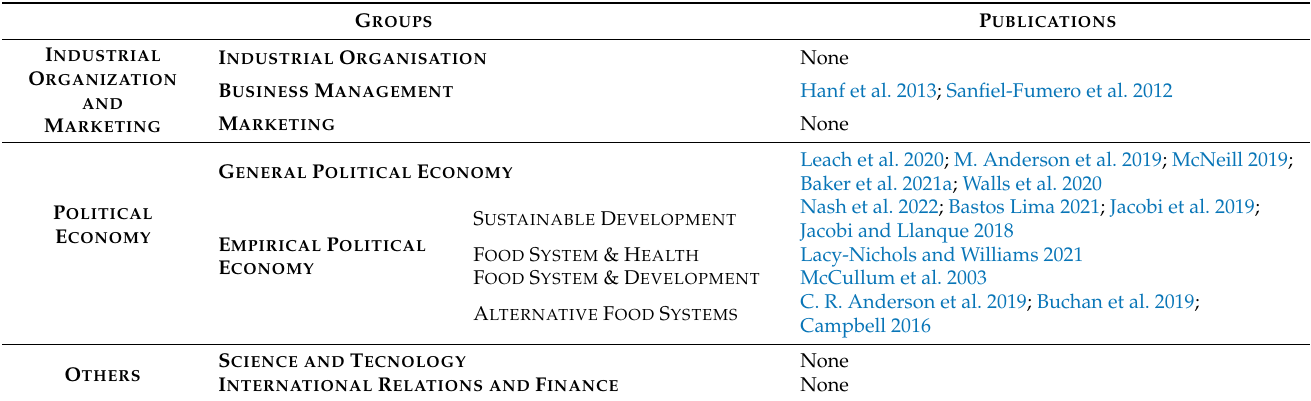
Table 1. Articles with references to the literature on the theory of power (16 records)—chronological order in descending